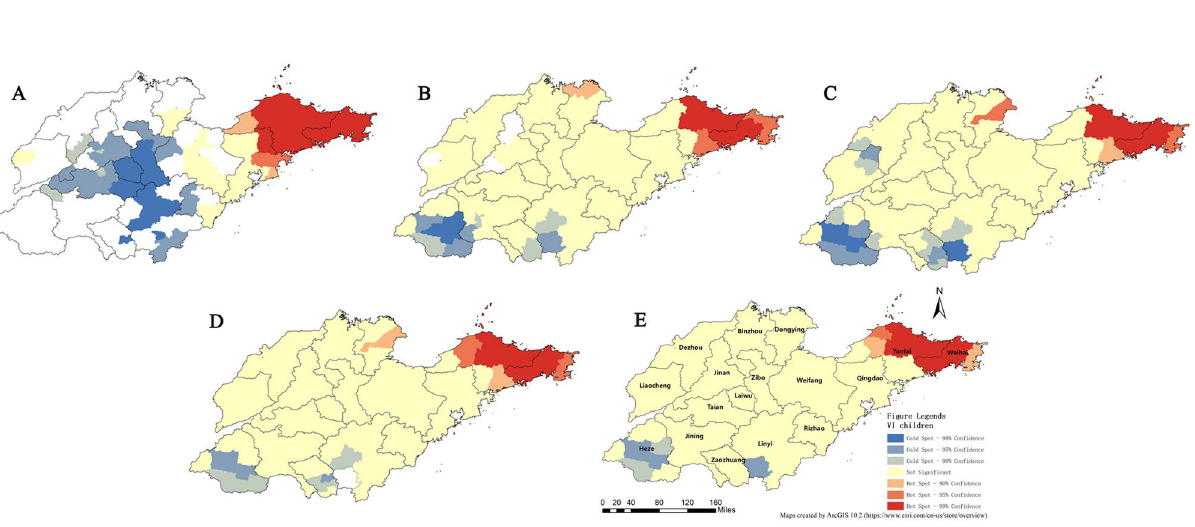
Figure 5. Spatial aggregation of visual impairment (VI) among children in Shandong province from 2013 to 2017. Figure Legends: Labels A to E represent the spatial cluster maps of each year from 2013 to